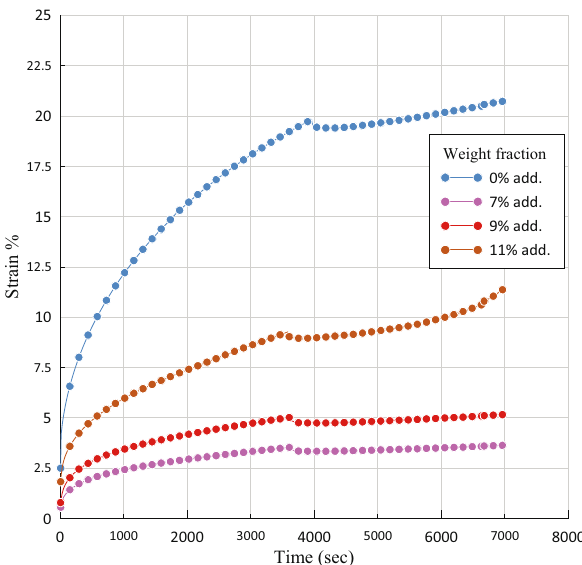
Figure 6: Strain versus time for UP/PS reinforced by di ff erent fi sh fl akes weight fractions at 20°C.